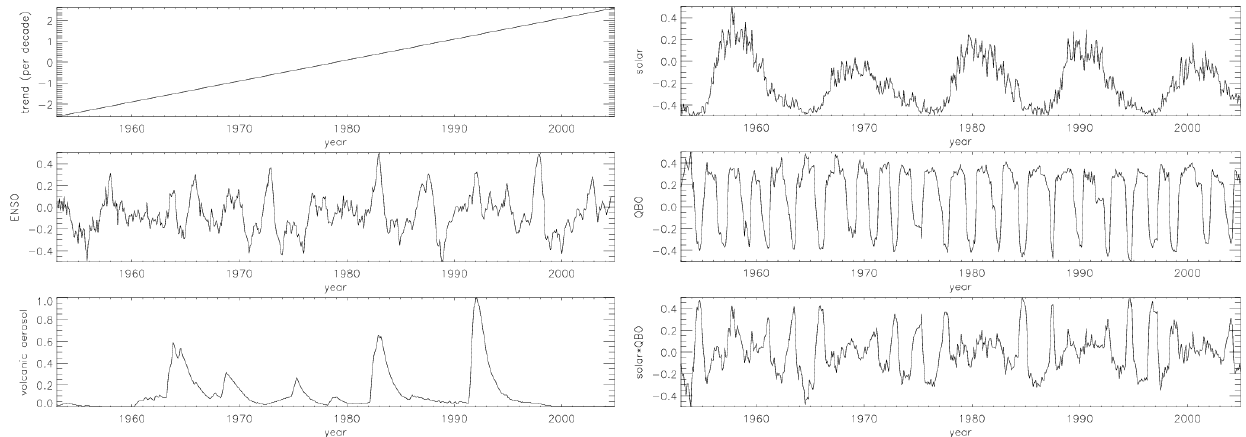
Figure 5 Time series used in the multiple regression. From the top: linear trend (per decade); normalised ENSO index; normalised stratospheric aerosol index; normalised sunspot number; normalised QBO (40hPa) index; compound solar * QBO index. The regression analysis uses either the solar and QBO indices or the compound index. After Haigh and Roscoe (2006)